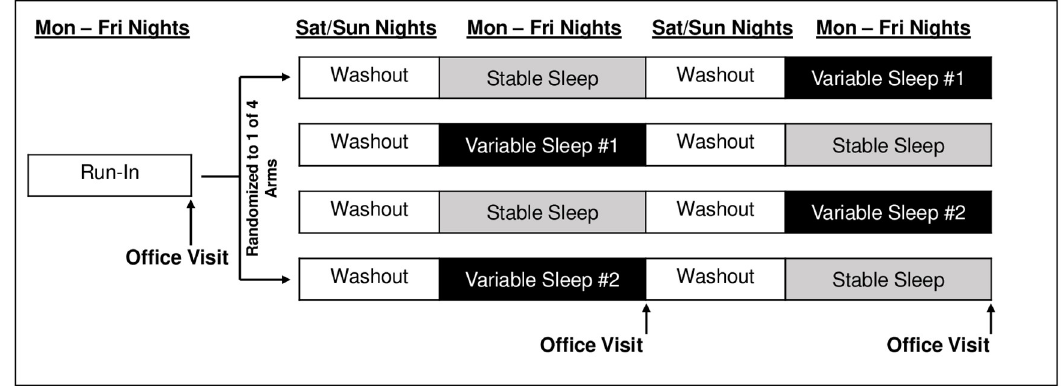
Fig 1. Depiction of the 3-week sleep manipulation protocol.